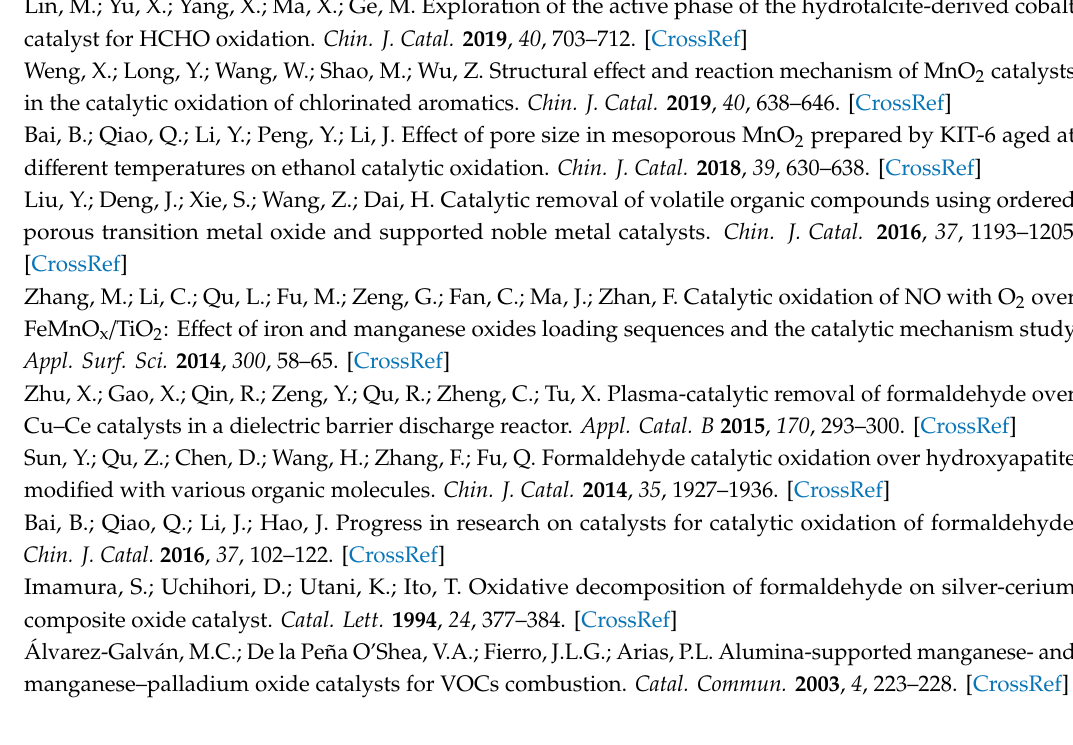
Figure S1. HCHO conversion as a function of temperature over the x wt % Eu / NaSep sample under the conditions of 2000 ppm HCHO + 20 vol % O 2 + N 2 (balance) and GHSV = 240,000 mL / (g h). Figure S2. In situ DRIFTS spectra of (a) Eu / NaSep, and (b) NaSep exposed to the flow of 2000 ppm HCHO + 20 vol % O 2 + N 2 (balance) at 30 ◦ C and di ff erent